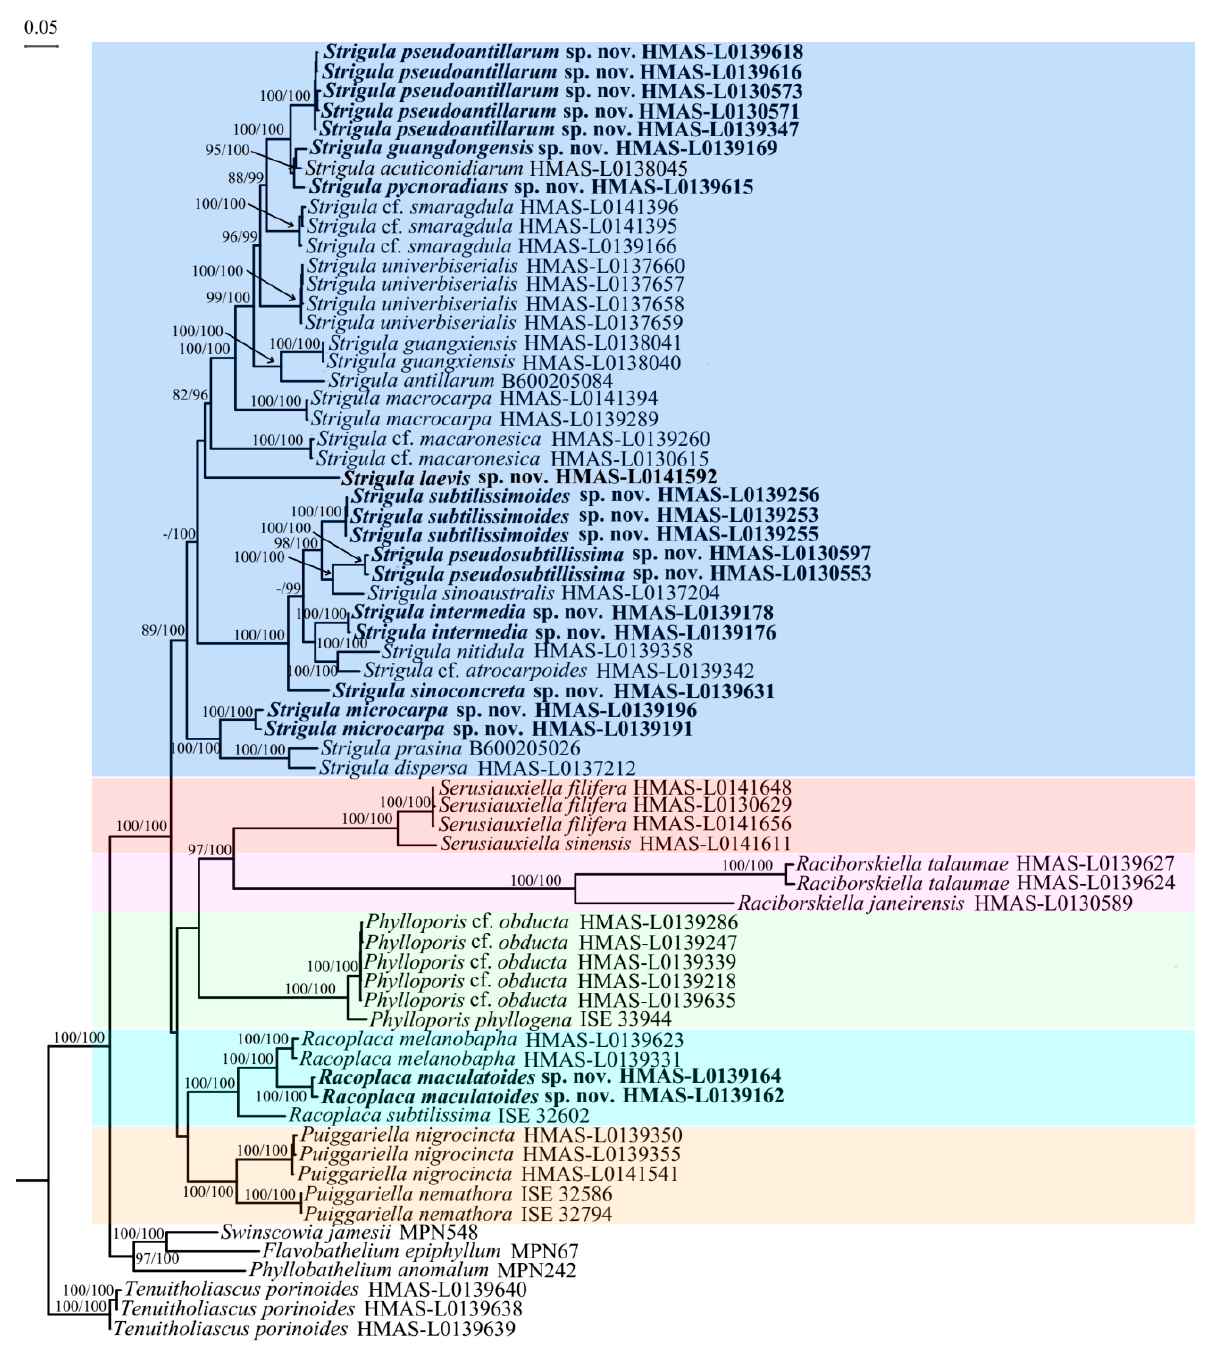
Figure 2. Phylogenetic tree constructed through ML analyses based on four markers (nuSSU, nuLSU, TEF1- α , and RPB2), with a total alignment length of 4373 bp. Maximum likelihood bootstrap support value above 70% ( left ) and Bayesian inference posterior probabilities above 95% ( right ) are shown above branches (ML ‐ BS/B ‐ PP). Terminals in boldface indicate newly generated sequences for this study.